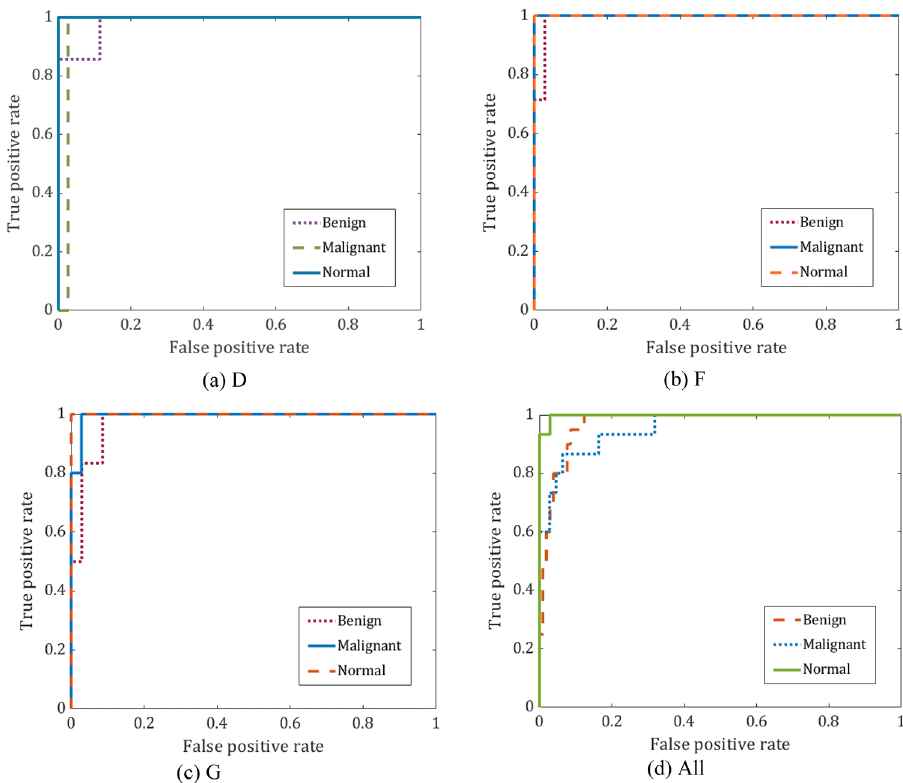
Figure 5. ROC curves of proposed mothed.